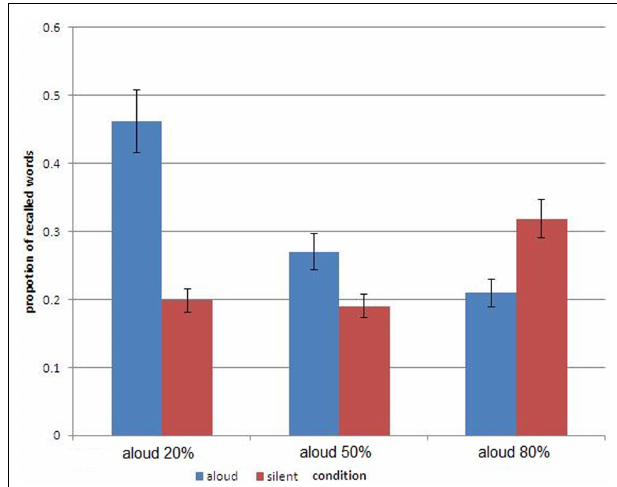
FIGURE 1 | Percentage of recalled words, calculated separately for the subsets of aloud and silent words, in three groups defined by the size of the subset of the aloud words. The bars represent one standard error around the